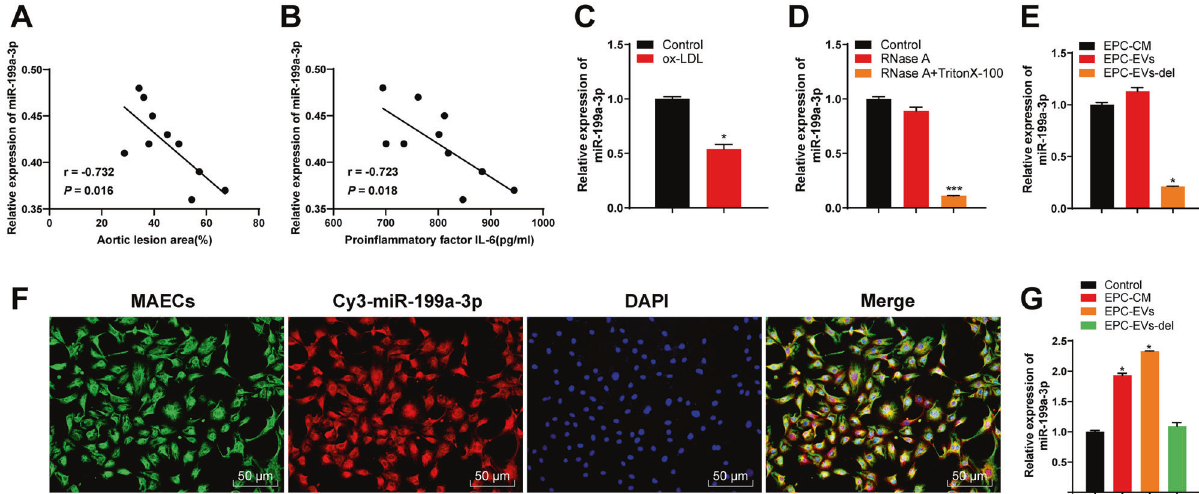
Fig. 2 EPC-EVs carried miR-199a-3p into ECs. A The relationship between miR-199a-3p expression in ApoE-/- mouse aorta and the area of aortic plaque. B The relationship between miR-199a-3p expression in ApoE-/- mouse serum and the serum content of pro-in fl ammatory factor IL-6. C miR-199a-3p expression in ECs before and after ox-LDL treatment was detected using qRT-PCR. D After EVs were treated with RNase A and detergent, miR-199a-3p expression was detected using qRT-PCR. E miR-199a-3p expression in EPC medium (EPC-CM) and EVs (EPC-EVs/- del) was detected using qRT-PCR. F EPC-EVs labeled with fl uorescent Cy3-miR-199a-3p into endothelial cells were observed under the confocal laser microscope (Cy3-miR-199a-3p-labeled EVs presented red and the nucleus presented blue after DAPI staining; phalloidin-labeled endothelial cells presented green) (scale bar = 50 μ m). G After ECs were co-cultured with EPC-EVs, miR-199a-3p expression in MAECs was detected using qRT-PCR. Each experiment was repeated three times independently. Measurement data are depicted as mean ± SD. The t test was used for the comparisons between two groups. One-way ANOVA was employed for the comparisons among multiple groups, followed by Tukey ’ s multiple comparisons test. * p <